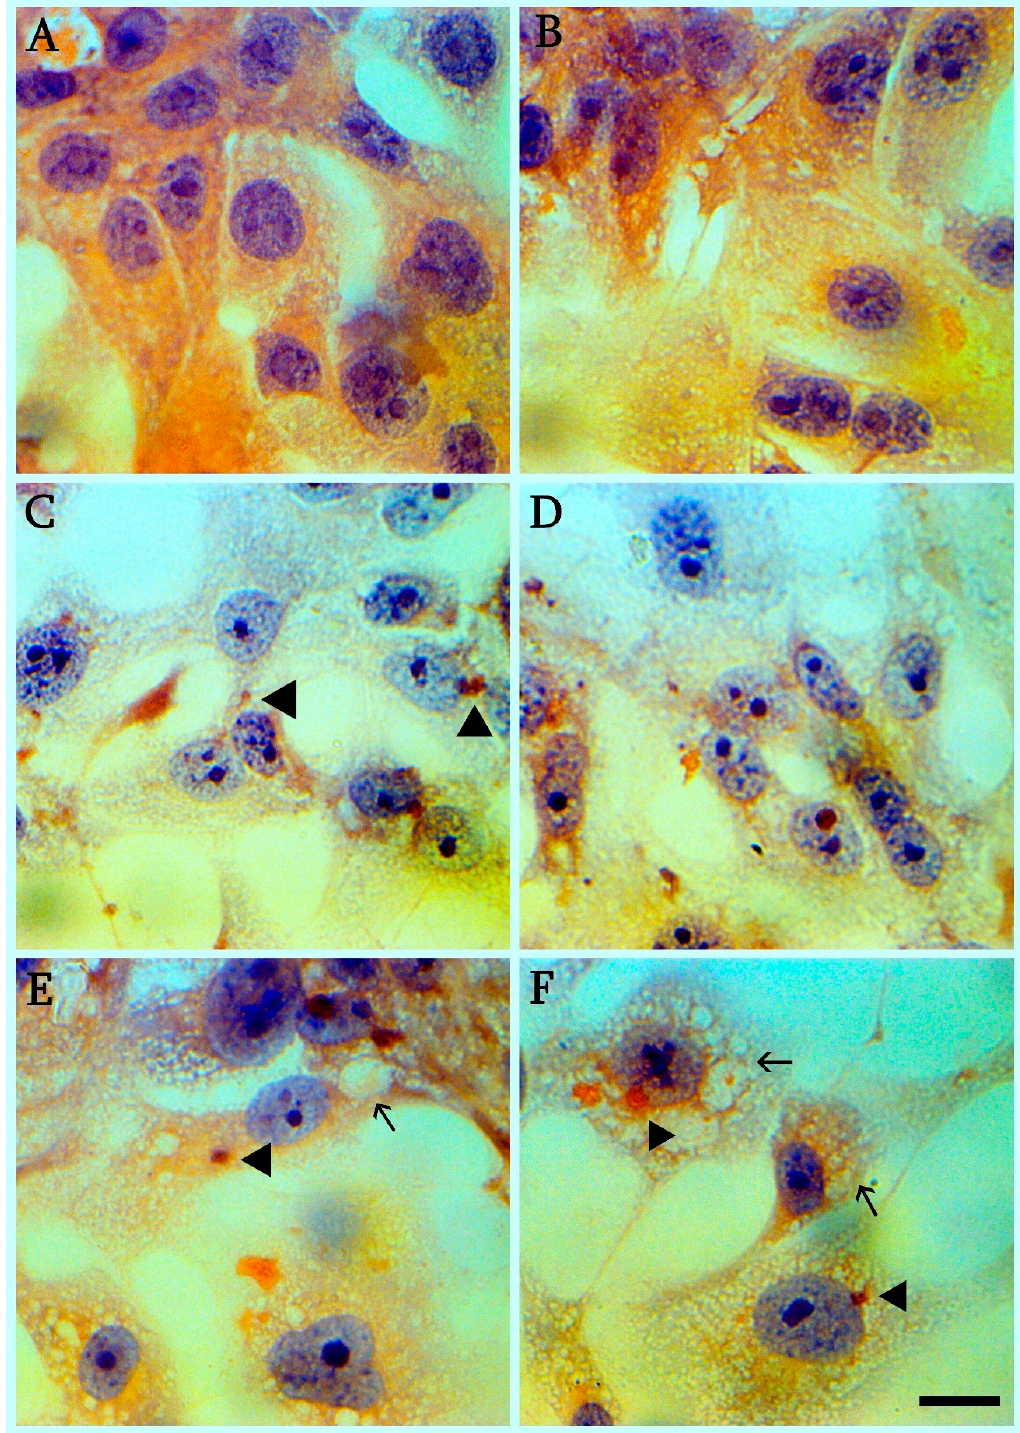
Figure 2. Cytopthic effect of SARS-CoV-2 on hematoxilin-eosin stained Vero E6 cells (120 hpi). ( A ) Mock-infected control cells ( B ) Mock-infected control cells ( C ) Cell size reduction, eosinophylic viral assemblies in infected cells (shown with triangle). ( D ) Cells size reduction and separation of cells from each other. ( E ) Eosinophylic viral assemblies in infected cells (shown with triangle) and vacuolization of the cytoplasm (arrowed). ( F ) Simultaneous vacuolization (arrowed) and formation of viral assemblies in same cell (shown with triangle); scale bar for ( A – F ) 10 μ m.